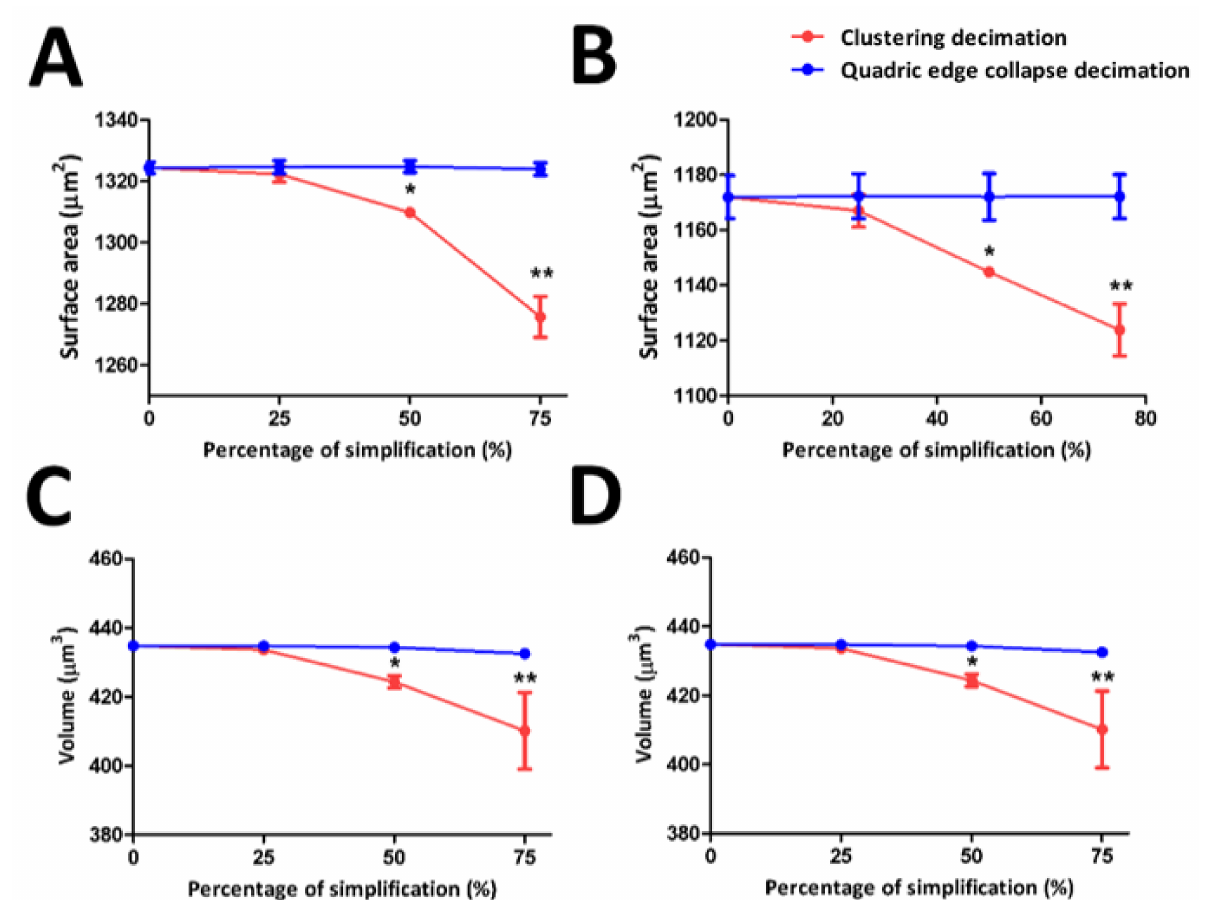
Figure 4. The surface area and volume of FtMt and LC3 3D models before and after simplification. ( A , B ). Surface area of FtMt and LC3 3D models before and after 25%, 50%, and 75% simplification through CD and QECD, respectively. There were no significant changes in the surface area of the FtMt model at 25% simplification through CD compared to the original model. However, there were significant changes in the volume of the model at 50% and 75% simplification compared to the initial volume of the FtMt and LC3 models, respectively. ( C , D ). Volume of the FtMt and LC3 3D models before and following 25%, 50%, and 75% simplification by CD and QECD, respectively. Comparing the FtMt model with a 25% simplification through CD to the original model, there were no significant changes in surface area. Nonetheless, the volume of the model at 50% and 75% simplification differed significantly from the initial volume of the FtMt and LC3 models, respectively. 0% indicates the original number of faces and vertices, respectively. * indicates a significant difference ( p < 0.05) at 50% simplification compared to the initial rendered model (0%). ** indicates a significant difference ( p < 0.05) at 75% simplification compared to the initial rendered model (0%). Data are presented as the mean ± standard deviation